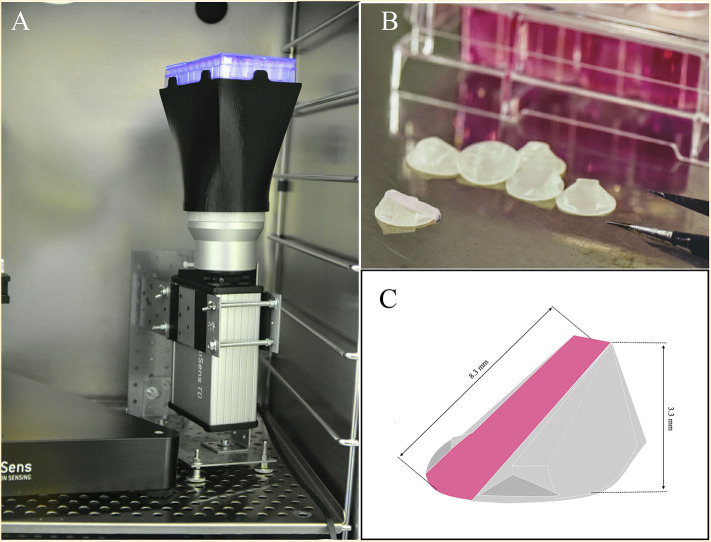
(A) Set-up of the VisiSens TD camera system used during the measurements. A cell culture plate is mounted on the plate support/base on the camera system. A light source located around the camera lens illuminates the cell culture plate from below to excite the oxygen sensor foils inside the wells. The VisiSens TD camera collects the ratiometric signal from the dyes on the surface of the sensors as they interact with the dissolved oxygen inside the cell culture media. (B) Image of the ramps with the sensors attached on their surface. (C) Schematic representation of the 3 D printed ramp and geometric details. The SF-RPsSu4 sensor was attached to the rectangular surface of the ramp.